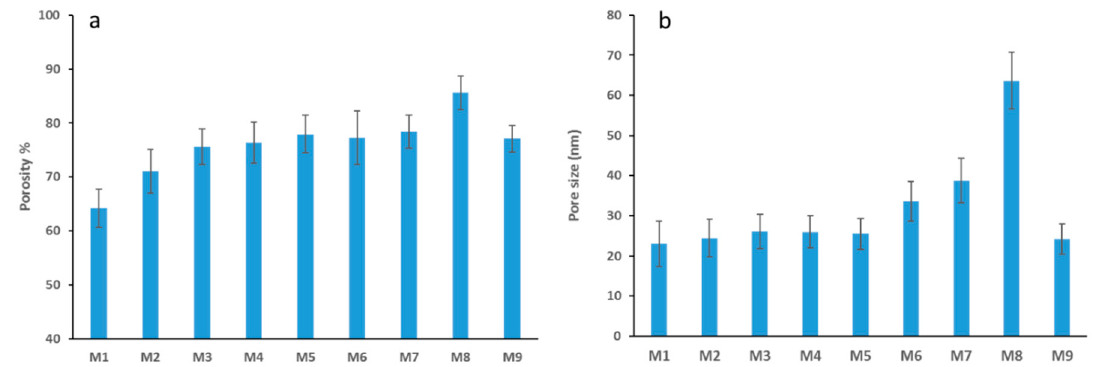
Figure 5. Average total porosity of PES membranes M1 to M9 ( a ), Average pore size for PES membranes M1 to M9 ( b ).